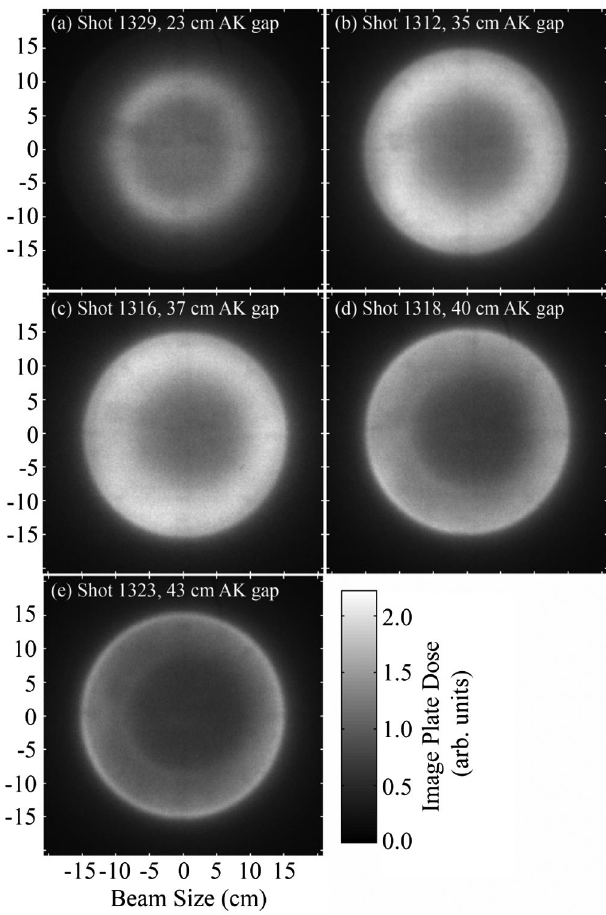
FIG. 7. Representative pinhole camera images for the 23, 35, 37, 40, and 43 cm AK gaps are shown in (a) – (e), respectively. The integrated image plate intensities were scaled to the TLD dose measurement at 1 m to achieve a relative intensity calibration between the images shown.